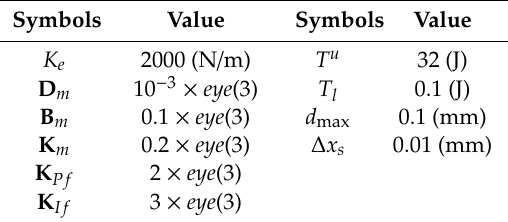
Table 3. Parameters of the contact-loss impedance